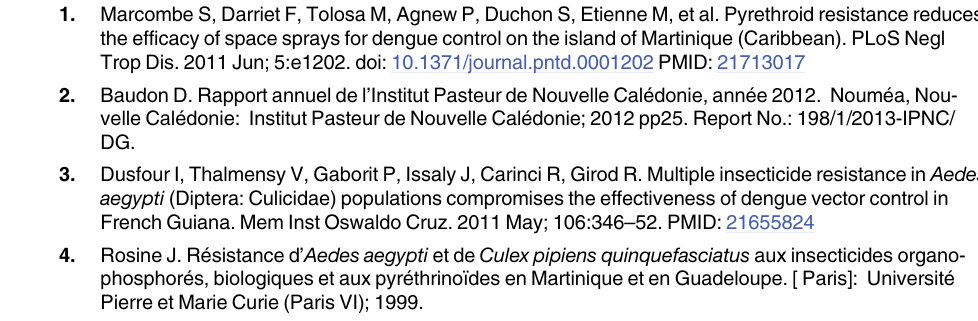
S1 Table. Quantitative PCR primer list for controlling gene expression in microarray. S2 Table. Allele frequencies within each population and susceptible (S) and resistant (R) group of mosquitoes. Four alleles were found ‘ 1016V + 1534F ’ called S, ‘ 1016V + 1534C ’ (1534 kdr ) called R1, ‘ 1016I + 1534 C ’ called R2 (1016 kdr +1534 kdr ) and ‘ 1016I + 1534 F ’ called R3 (1016 kdr ). Number of individual is also mentioned (N). S3 Table. List of genes significantly up and down regulated in the three studied